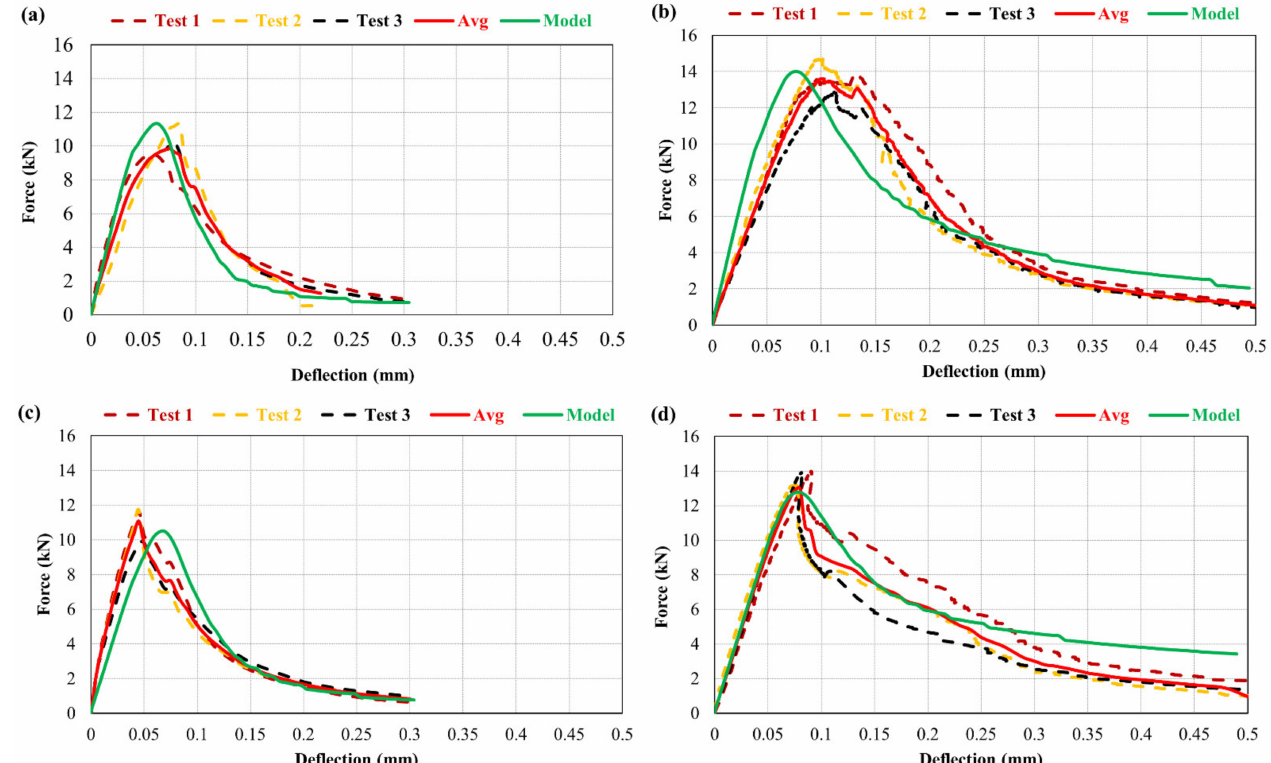
Figure 17. Force vs. deflection in composite beam for; ( a ) M0R0F-M0R0F, ( b ) M0R0F-M0R30F, ( c ) M0R0F-M30R0F, and ( d )